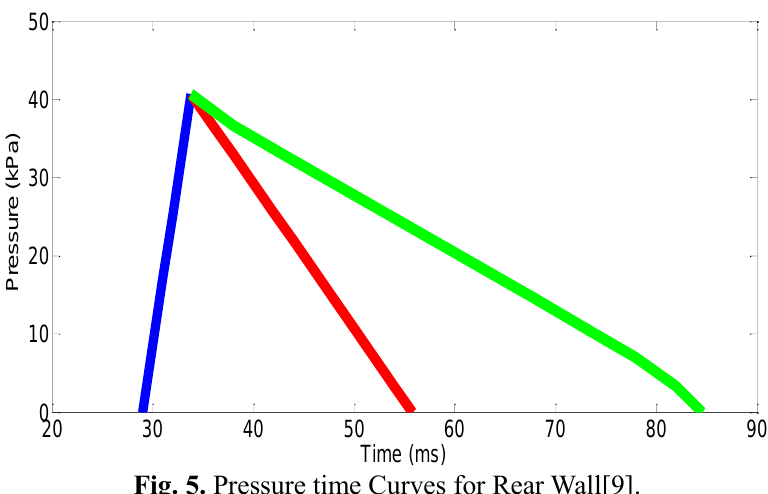
Fig. 5. Pressure time Curves for Rear Wall[9].